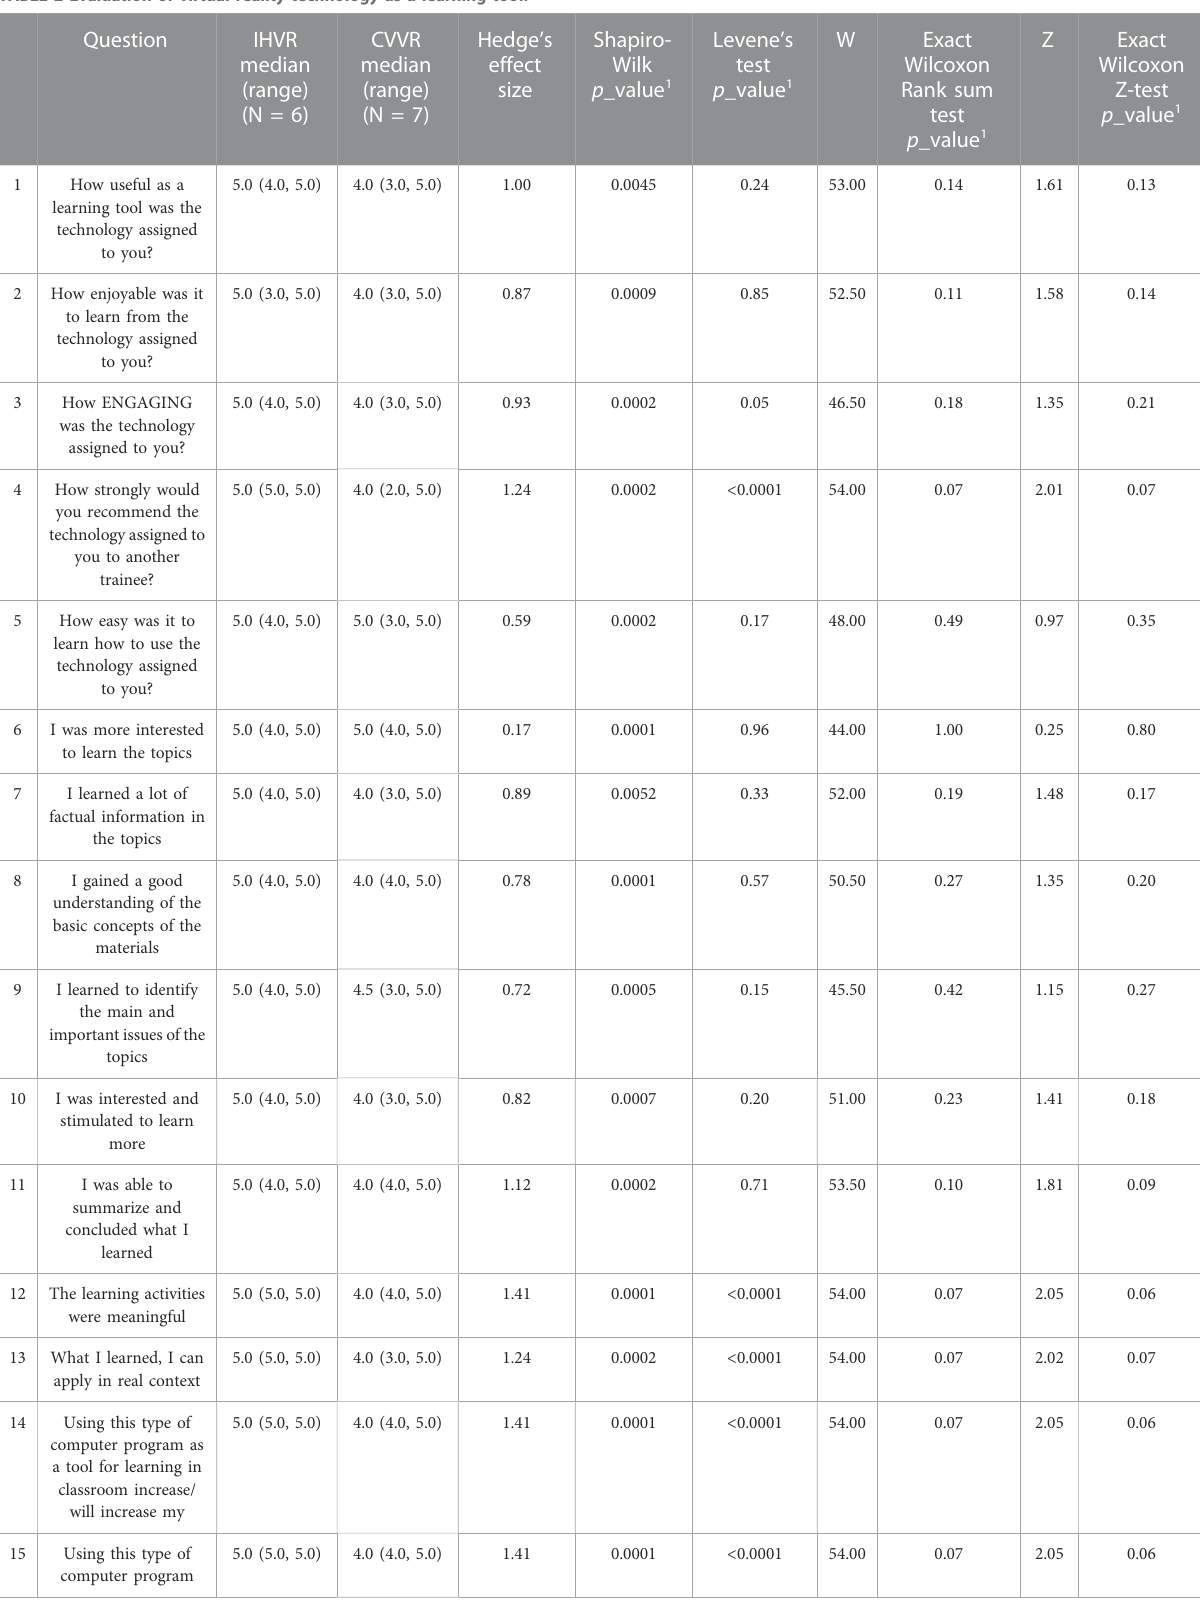
TABLE 2 Evaluation of virtual reality technology as a learning